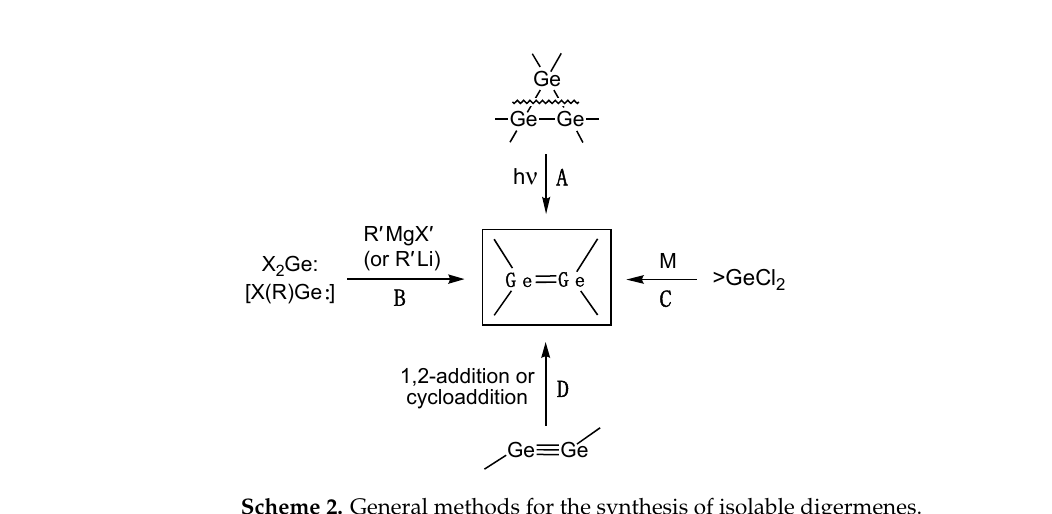
4 of 36 Scheme 1. Synthesis of the first isolable digermene Dis2Ge=GeDis2 1 . Since 1976, numerous digermenes have been isolated and, in the majority of cases, structurally characterized, with most of these cases being reported after 2000. The synthetic strategies toward stable digermenes can be categorized into the four main approaches: (1) photolysis of cyclotrigermanes (route A ); (2) reduction of dihalo- or monohalogermylenes with Grignard or organolithium reagents (route B ); (3) reductive dehalogenation of 1,1-dihalogermanes (route C ); and (4) 1,2-addition or cycloaddition to digermynes (route D ) (Scheme 2). Route A (photolysis of hexaarylcyclotrigermanes) is mostly of a historical importance as the method employed by Masamune and coworkers for preparation of the first